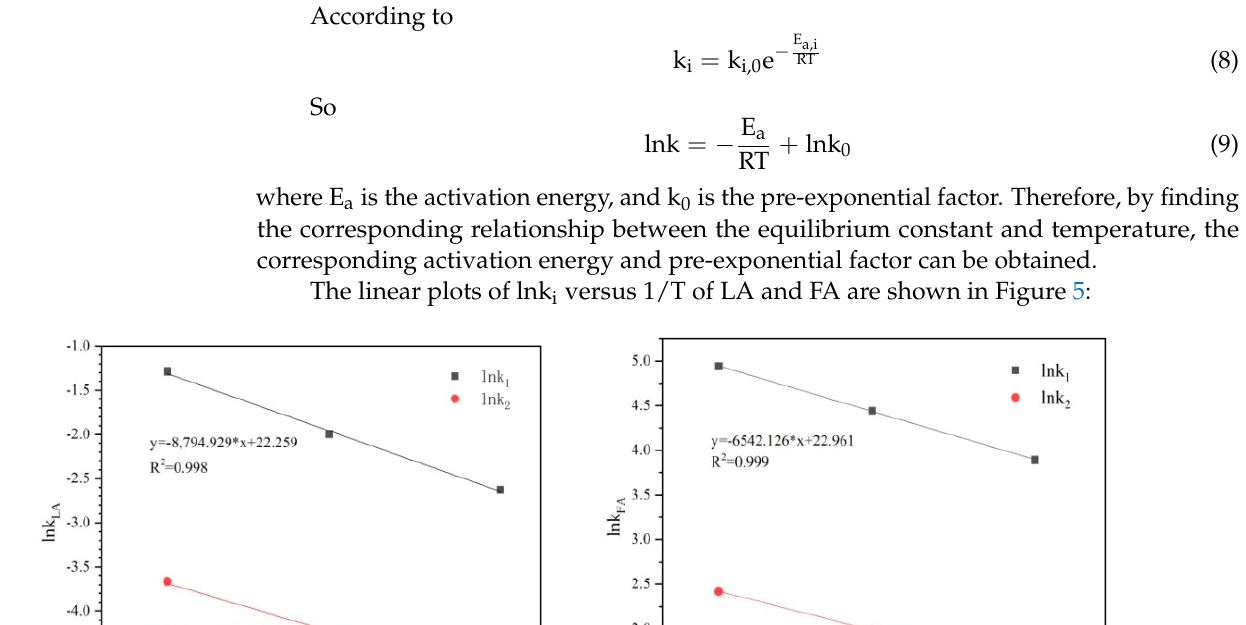
Figure 4. Reaction equilibrium equations of ( a ) LA and ( b ) FA.